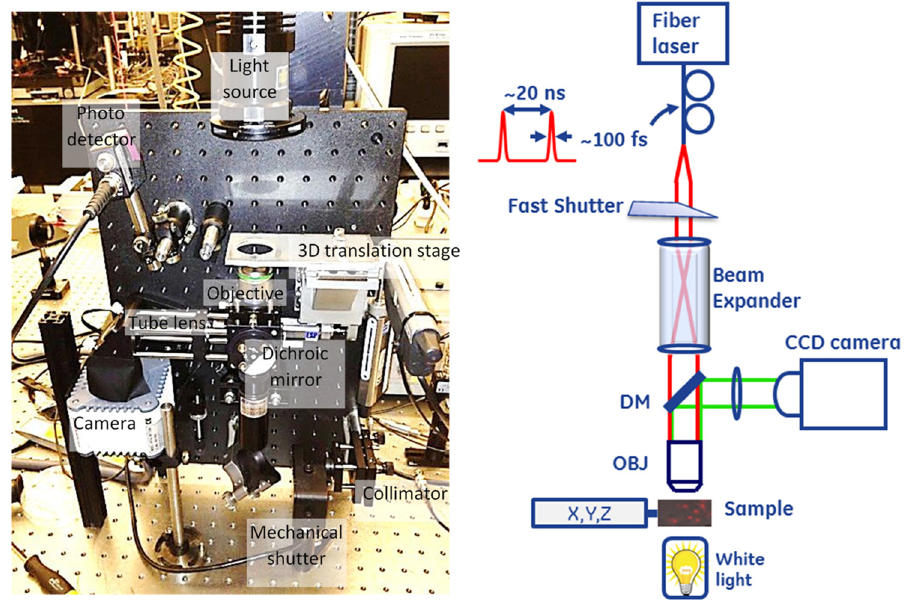
Figure 1. ( Left ) Photograph and ( right ) schematic of the experimental setup used for infrared (IR) single cell laser injection.